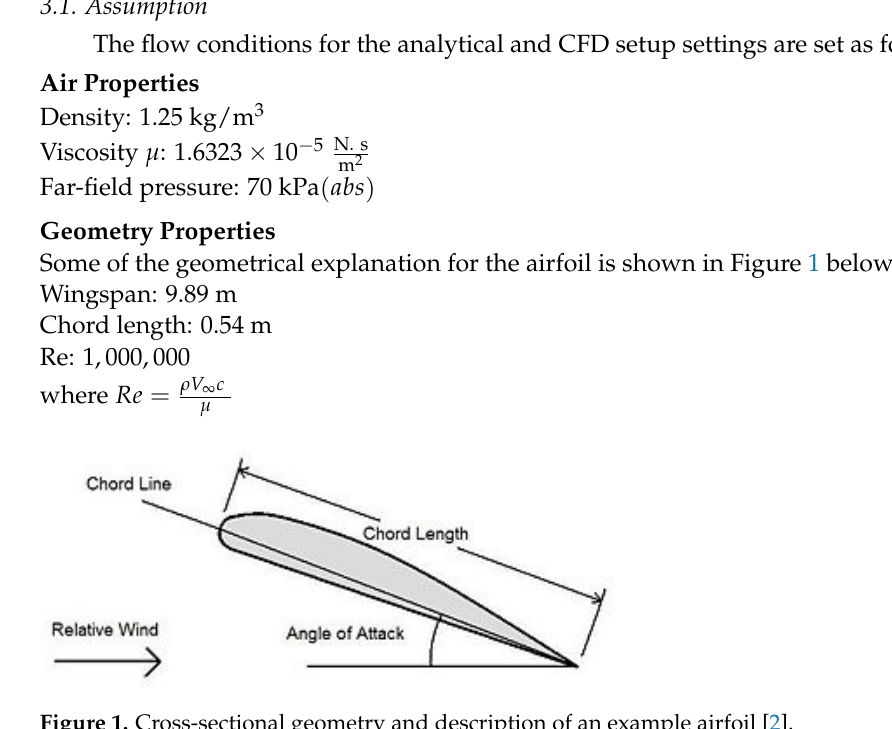
Figure 2. NACA2410-2410 wing and its dimensions.